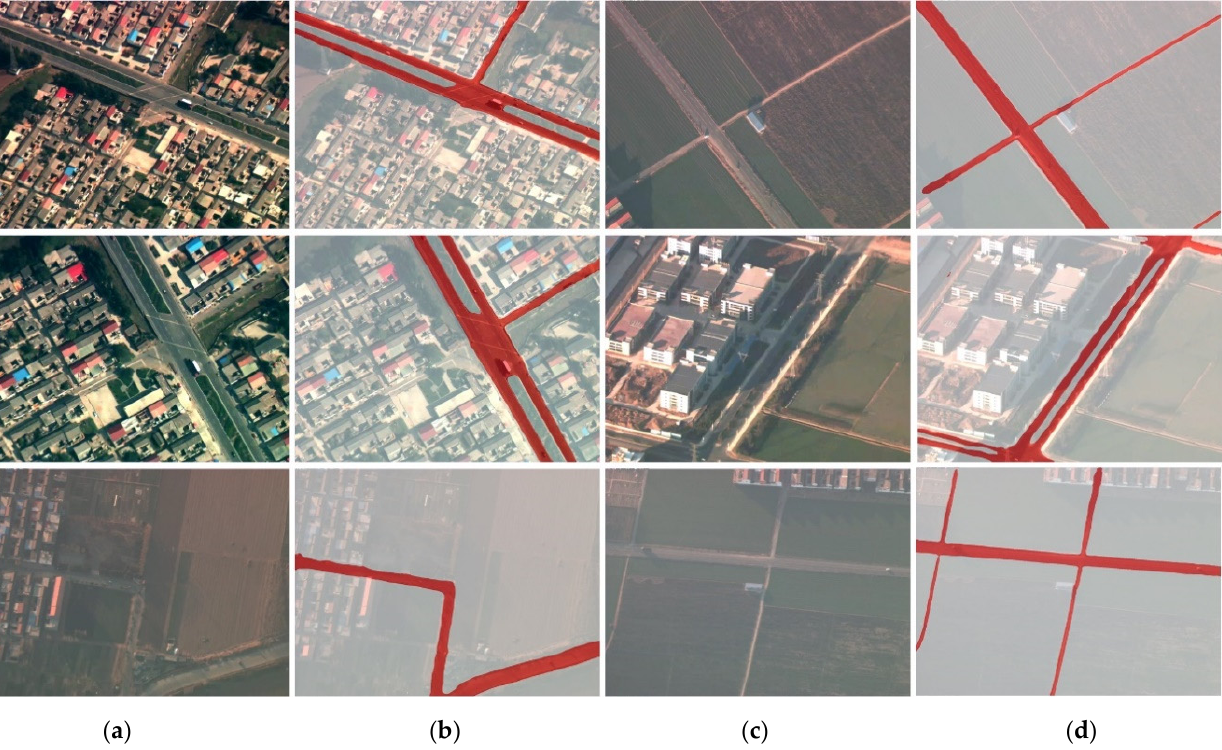
Figure 4. Visualization results of road segmentation. ( a , c ) Columns are the original images, ( b , d ) columns are the corresponding segmentation results, respectively, and the red markings represent the road area.